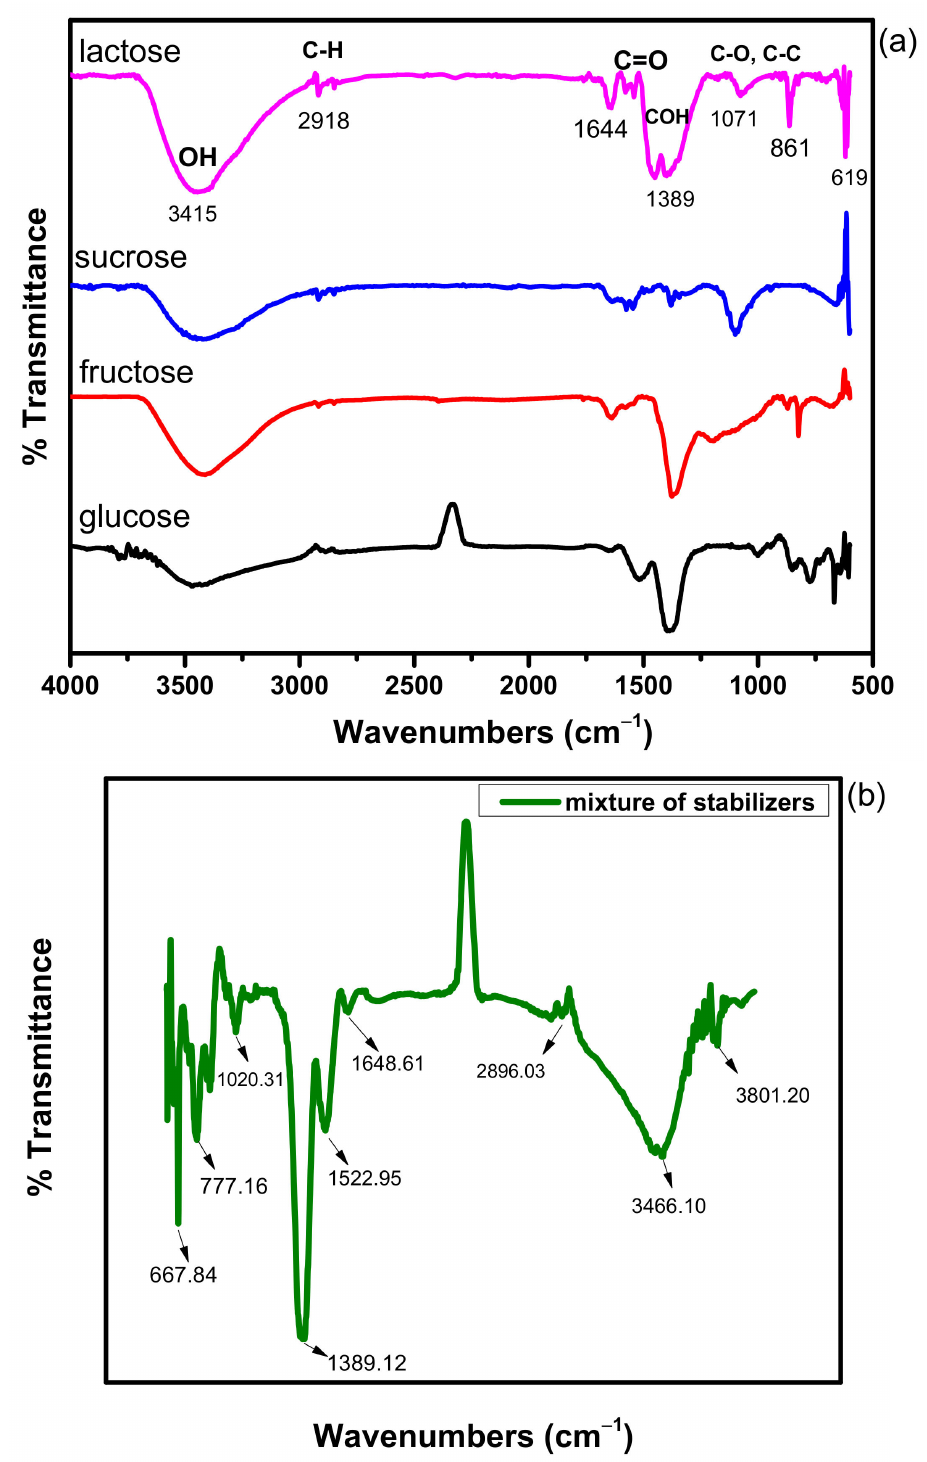
Figure 6. ( a ) FTIR spectra of AgNPs synthesized using pure stabilizers and ( b ) an optimized mixture of